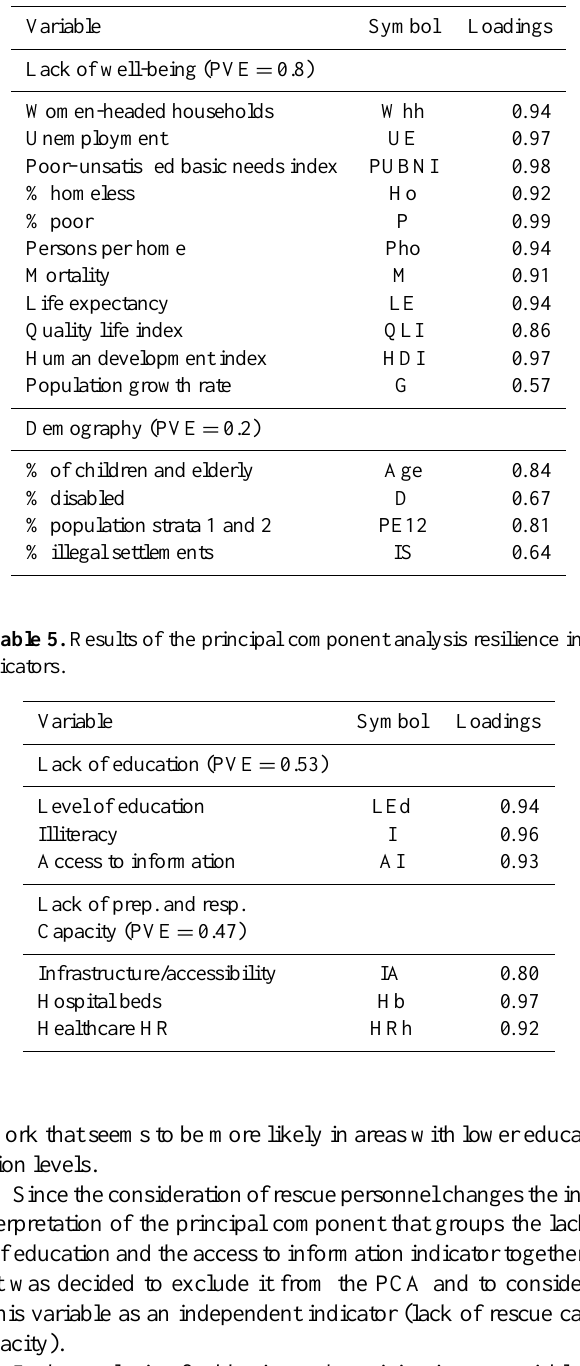
Table 4. Results of the principal component analysis for socio- economic fragility indicators.